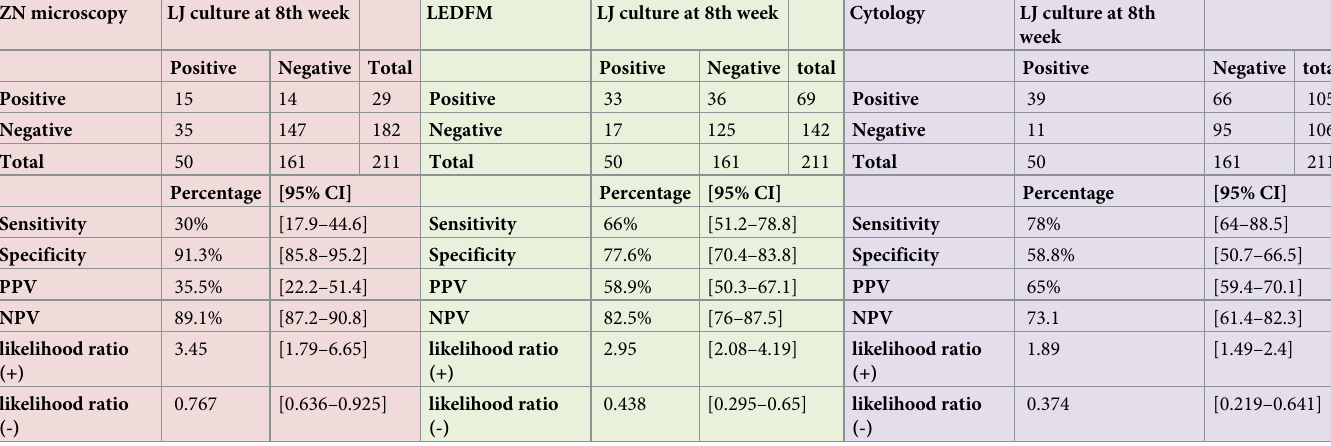
Table 3. Diagnostic accuracy of ZN, LEDFM, and cytology microscopy against culture result data drown from ALERT and St. Peter TB specialized hospital, Addis Ababa, Ethiopia. (n = 211) (2020).